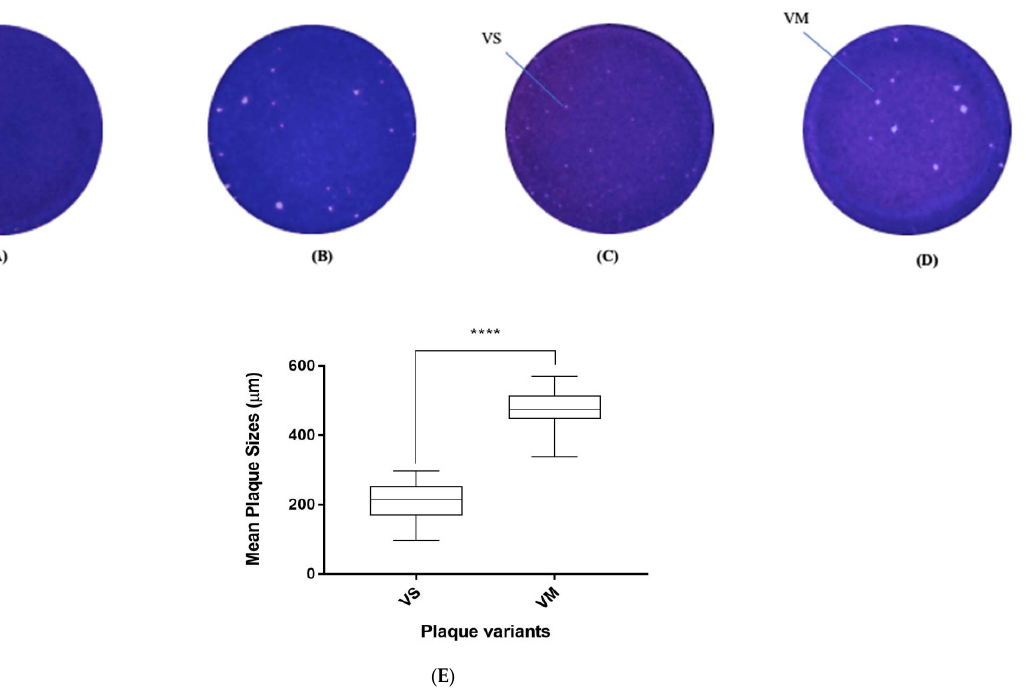
Figure 4. Six-well plates containing Vero cells with 70–80% confluency were infected with the EV- A71/WT after ( A ) 1st passage (P1) and ( B ) 5th passage (P5). ( C ) Plaque morphology of EV-A71/VS plaque variant and ( D ) EV-A71/VM plaque variant after 5th passage. The plaques were visualized 72 h post-infection (h.p.i.) after staining with crystal violet. Plaques were observed and images were captured with Immunospot ® S6 VERSA Analyzer (Cellular Technology Limited, USA). ( E ) Diameters of 40 plaques representing each plaque variant in monolayers of Vero cells were measured using the DS-L3 viewer with the Nikon’s NIS-Elements software and analyzed by Graph pad prism 7.04. The mean size of the EV-A71/VS variant was compared against the mean plaque size of the EV-A71/VM variant in Vero cells. Error bars indicate standard deviation of average. Statistical analysis, unpaired t -test, **** p